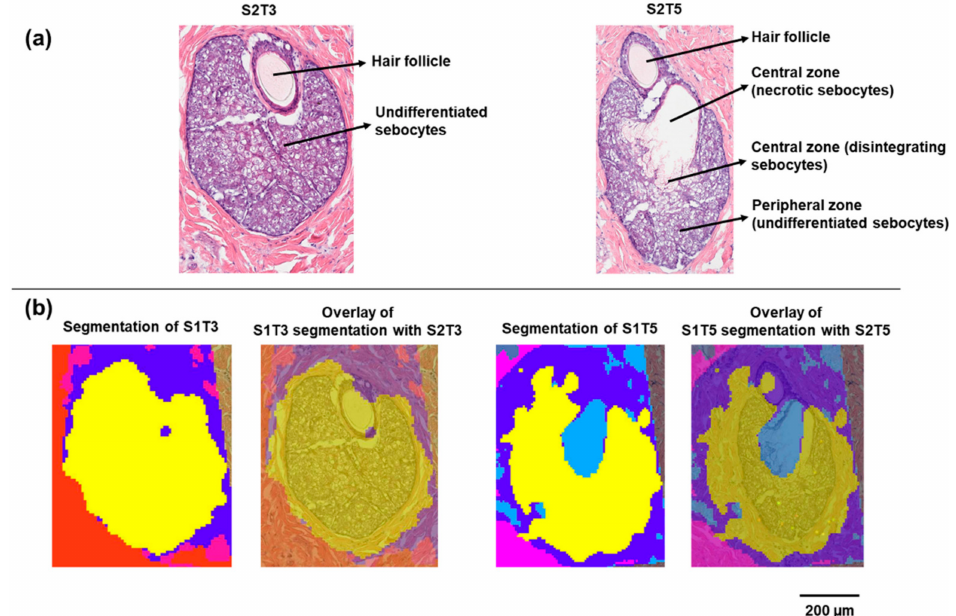
Figure 1. Histology and segmentation analysis of sebaceous glands on minipig skin sections: ( a ) H&E staining of the sebaceous glands on sections S2T3 and S2T5; ( b ) segmentation clustering of the sebaceous glands on S1T3 and